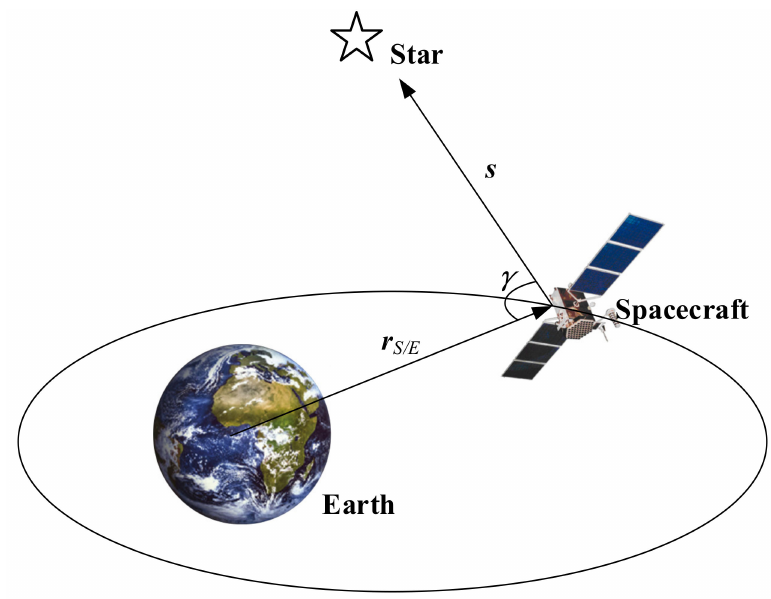
Figure 4. Graphic description of stellar angle